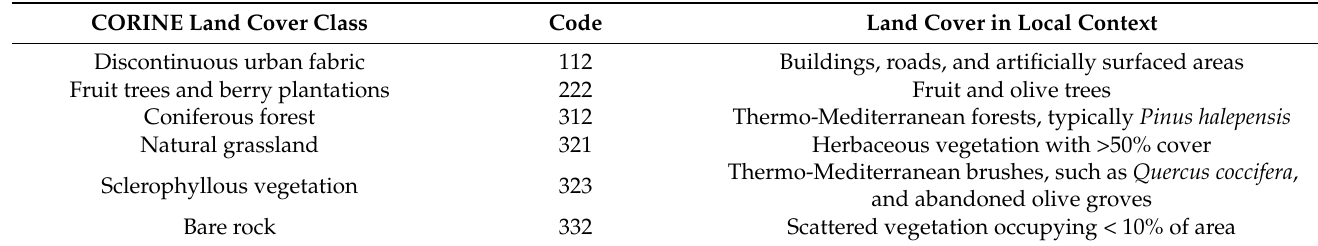
Table 1. CORINE Land Cover categories identified in the study